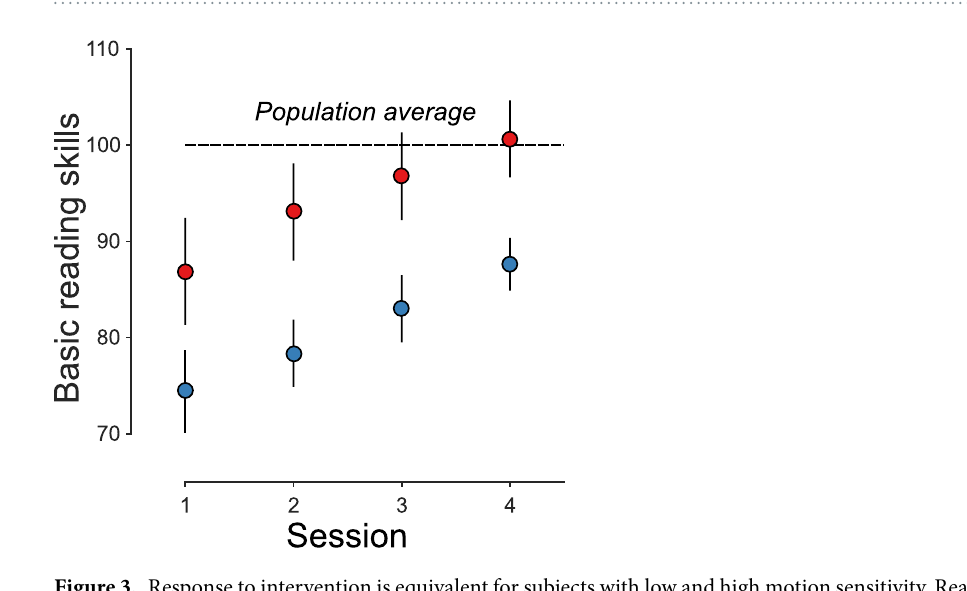
Figure 2. Intervention improves reading skills but not motion sensitivity. ( a ) Intervention effects. Reading skills improved significantly during the reading intervention. Reading skills are plotted as a function of time in the intervention (circle). The population average (50 th percentile) reading score is shown for reference. ( b ) Motion processing learning effects. Motion discrimination threshold (percent coherence) is plotted as a function of experimental block. Subjects completed three blocks during each measurement session. The black line is the best-fitting exponential decay function to the data. The shaded area is ± 1 SEM of the mean threshold in block 3 of session one (pre-intervention). Thresholds decline over the first three blocks as the subjects learn the task and then reach a stable level with no change over the intervention. Error bars represent ± 1 SEM across subjects.